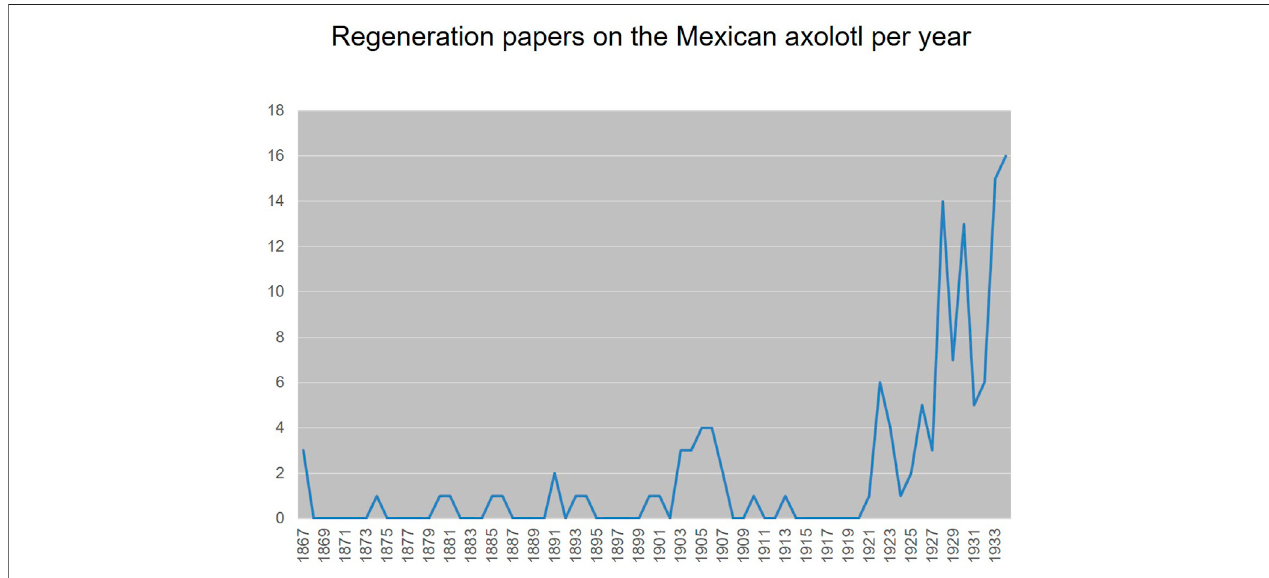
FIGURE 1 | Papers on regeneration in the axolotl from 1864 to 1933. For the data basis, see Reiß